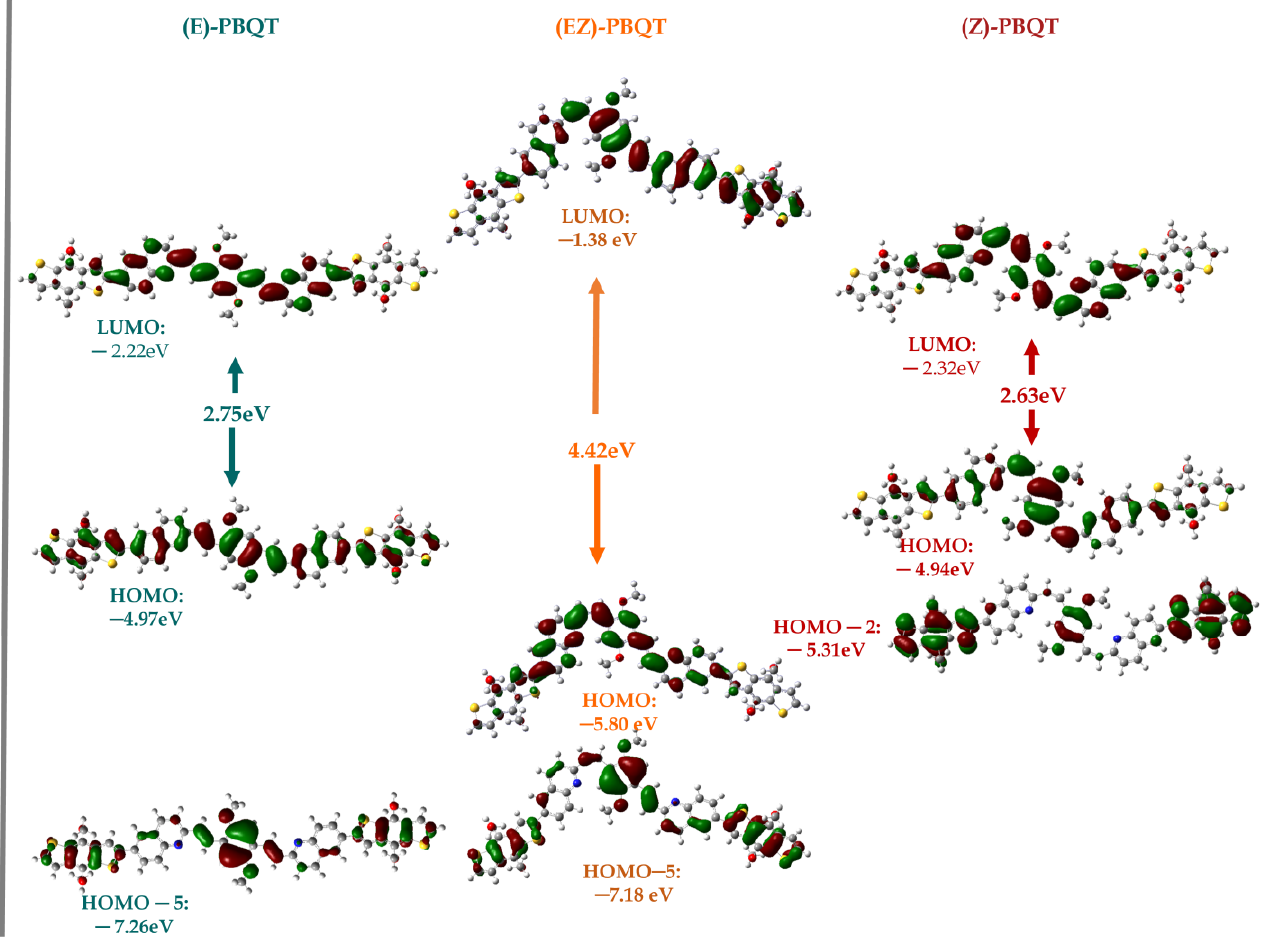
Figure 3. Isoimages of the molecular orbitals of PBQT , lateral chains were omitted for computational purposes.